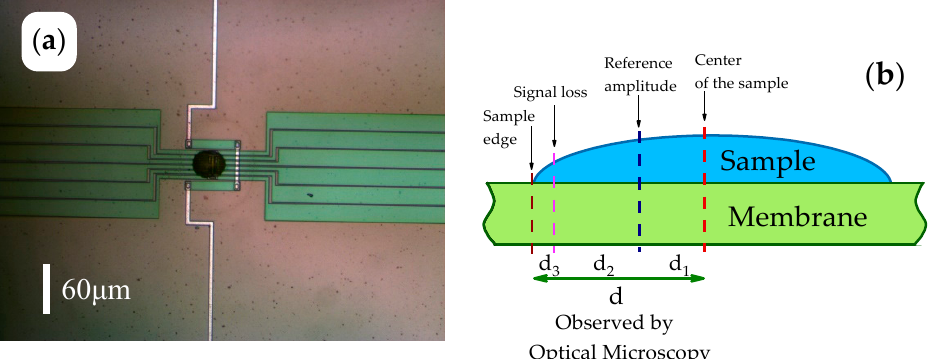
Figure 3. ( a ) Optical microscope image of a poly(ether ether ketone) (PEEK) sample on the chip-sensor. ( b ) Schematics of setting the reference amplitude of the cantilever for the AFM measurement.